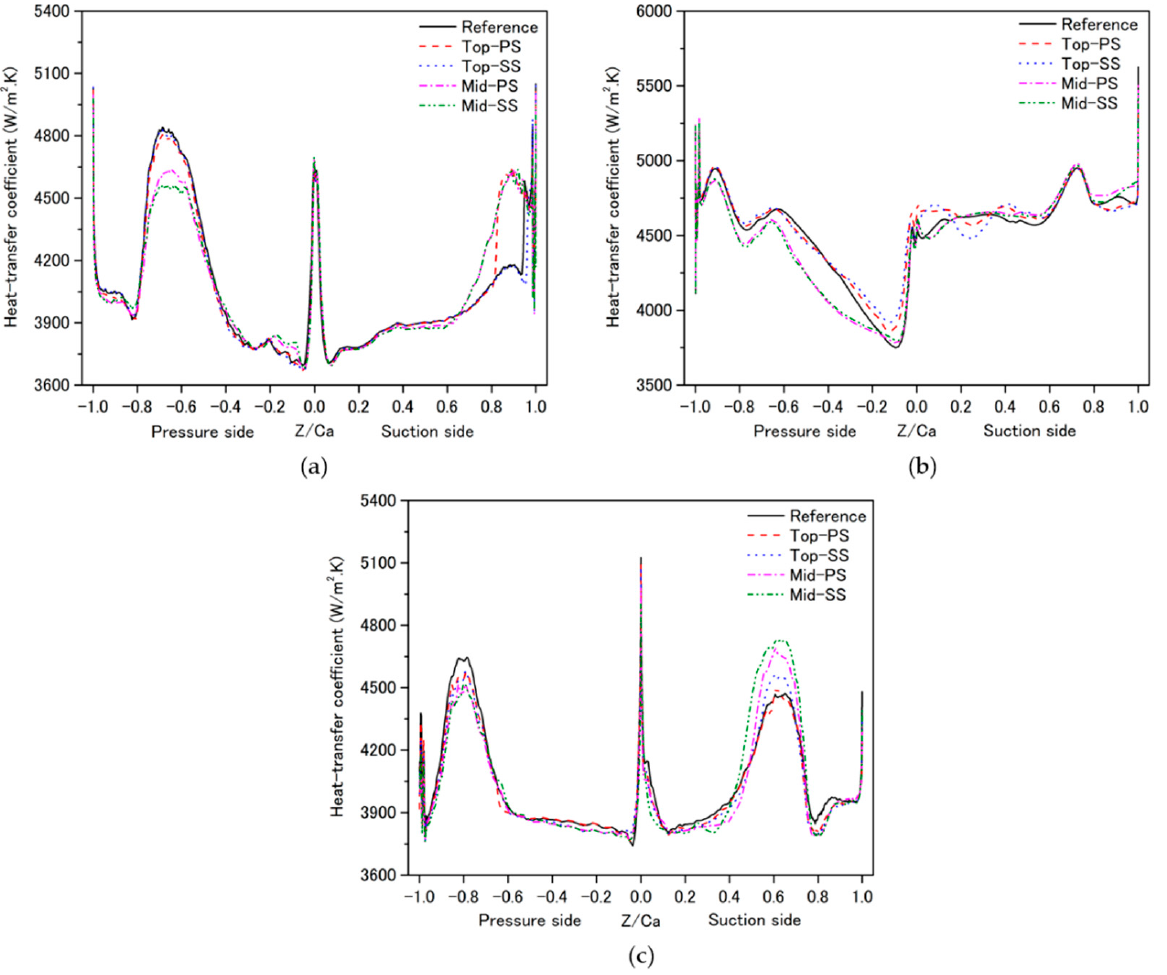
Figure 19. Heat-transfer coefficient at different spanwise locations of the S 2 vane under different damaged-blade conditions: ( a ) hub; ( b ) midspan; ( c ) shroud.